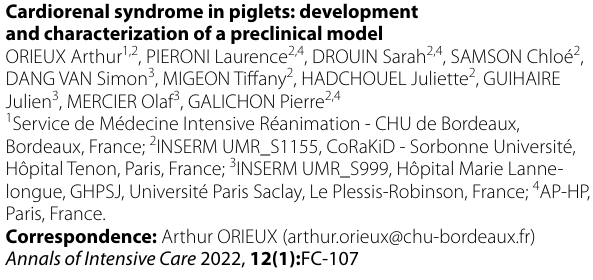
Figure 1. Study protocol of pulmonary hypertension induction. D: day; E: embolization; mGFR: measured glomerular filtration rate; LPA: left pulmo- nary artery; PH: pulmonary hypertension; RHC: right heart catheteriza- tion; TTE: transthoracic